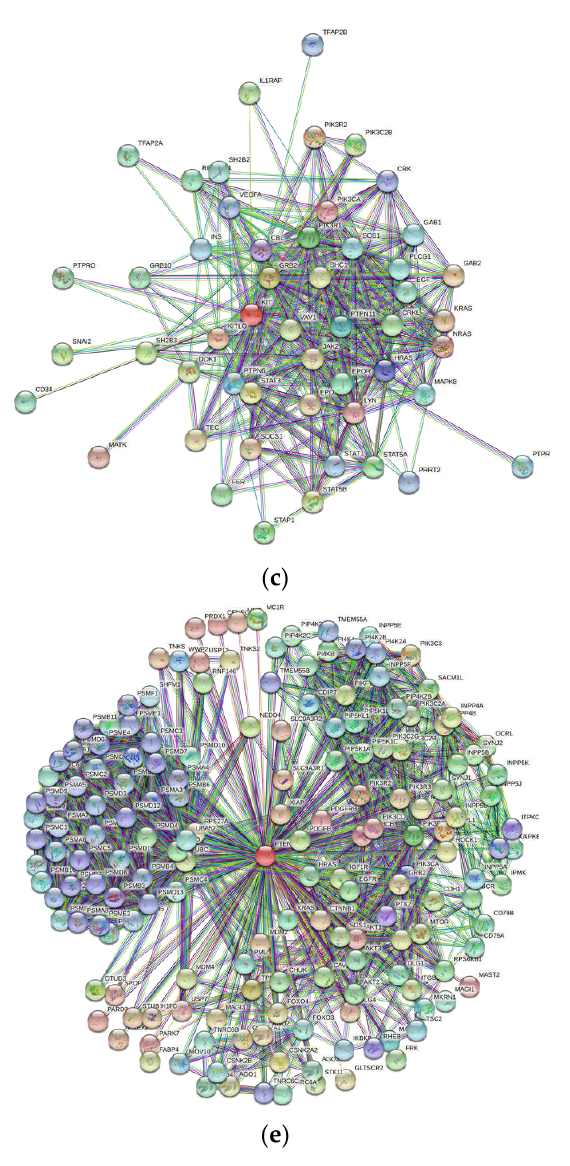
Figure 6. Search Tool for the Retrieval of Interacting Genes (STRING) output for ( a ) BRAF, ( b ) NRAS, ( c ) c-KIT, ( d ) NF1, and ( e ) PTEN. This analysis shows multiple proteins (circles) and their extensive interaction network (lines) for the five proteins involved in the pathogenesis of conjunctival melanoma. This demonstrates very complex protein binding ability beyond the MAPK and PI3-akt pathways. The ability of these proteins to interact in an extensive interaction network is possible through intrinsically disordered protein regions. Table 3. Search Tool for the Retrieval of Interacting Genes (STRING) analysis with mutations known to be associated with the development of conjunctival melanoma.